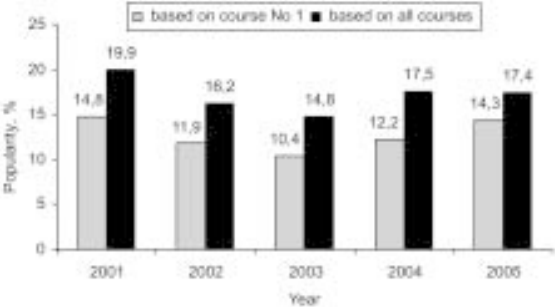
Fig 4. Popularity of a course of studies in technological sciences, in per cent (the number of applicants to all courses of studies is assumed to be equal to 100 %)